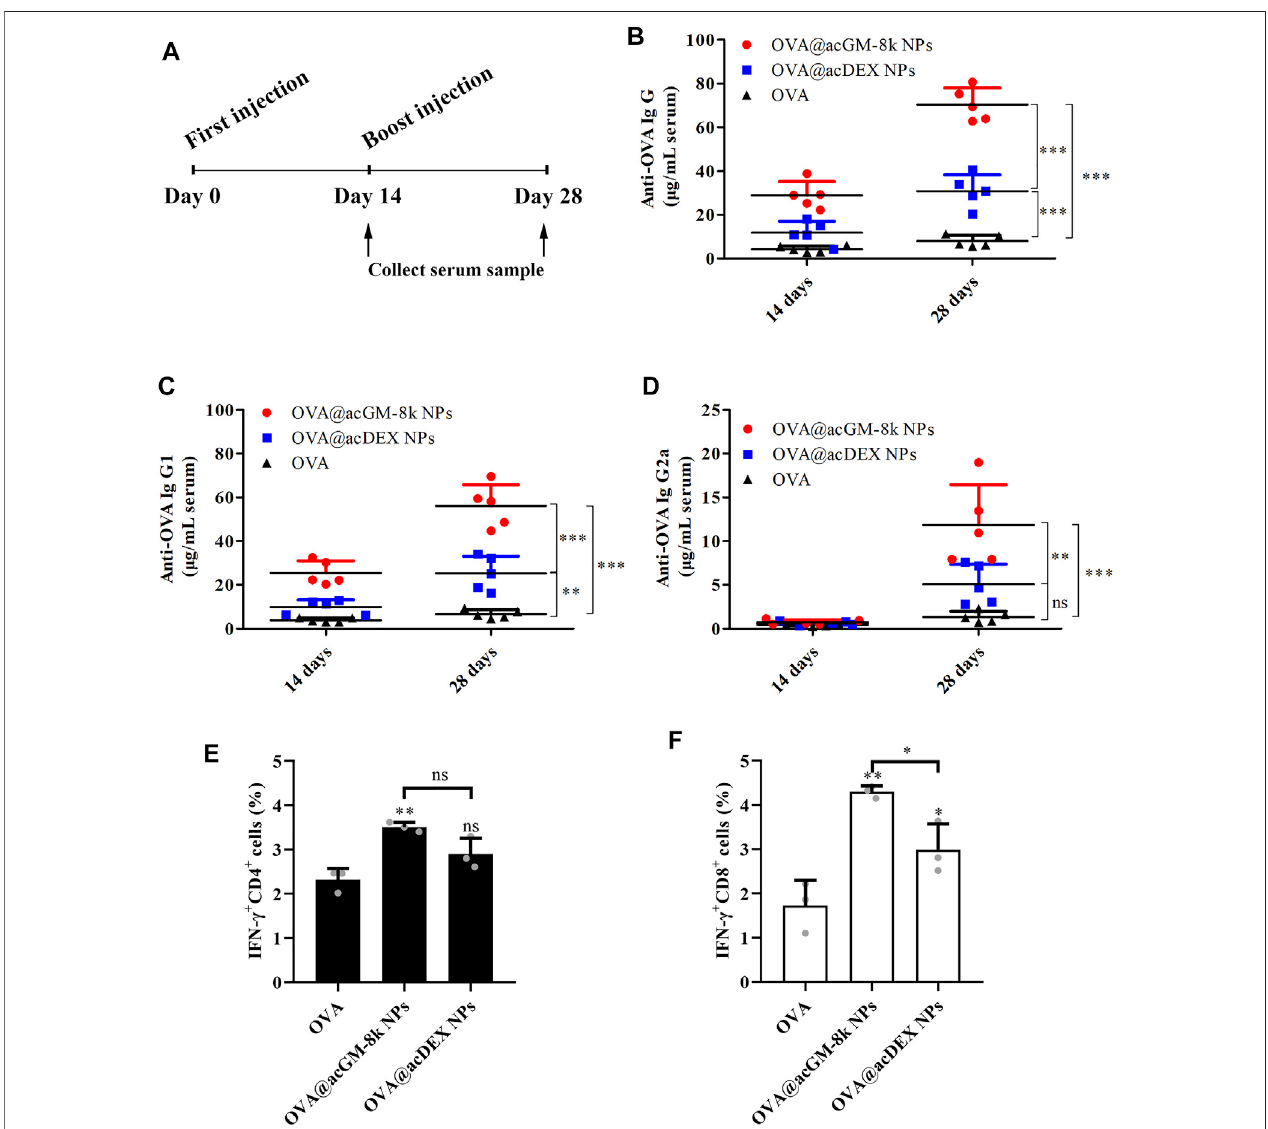
FIGURE 7 | OVA@acGM-8k NPs enhanced the humoral and cellular immune response. (A) Schematic of the experiment design. (B – D) Levels of anti-OVA IgG, IgG1, and IgG2a antibodies in serum were determined. (E – F) Splenocytes were restimulated with OVA (100 μ g/ml) or SIINFEKL (2 μ g/ml) for 6 h at 37 ° C; then, fl ow cytometry was used to determine percentages of OVA-speci fi c (E) IFN- γ – producing CD4 + T cells and (F) IFN- γ -producing CD8 + T cells. * p < 0.05, ** p < 0.01, *** p < 0.001 vstheOVAgroup; ns: nosigni fi cance. For (B) – (D) ,datawereobtainedfrom fi vemice ineach group;For (E) – (F) ,datawereobtained fromthreemice ineach group. All numerical values are given as average values ± standard deviation. Statistical analysis was performed using Prism Software (GraphPad, United States), followed by one-way ANOVA analysis with Dunnett ’ s post hoc evaluation.